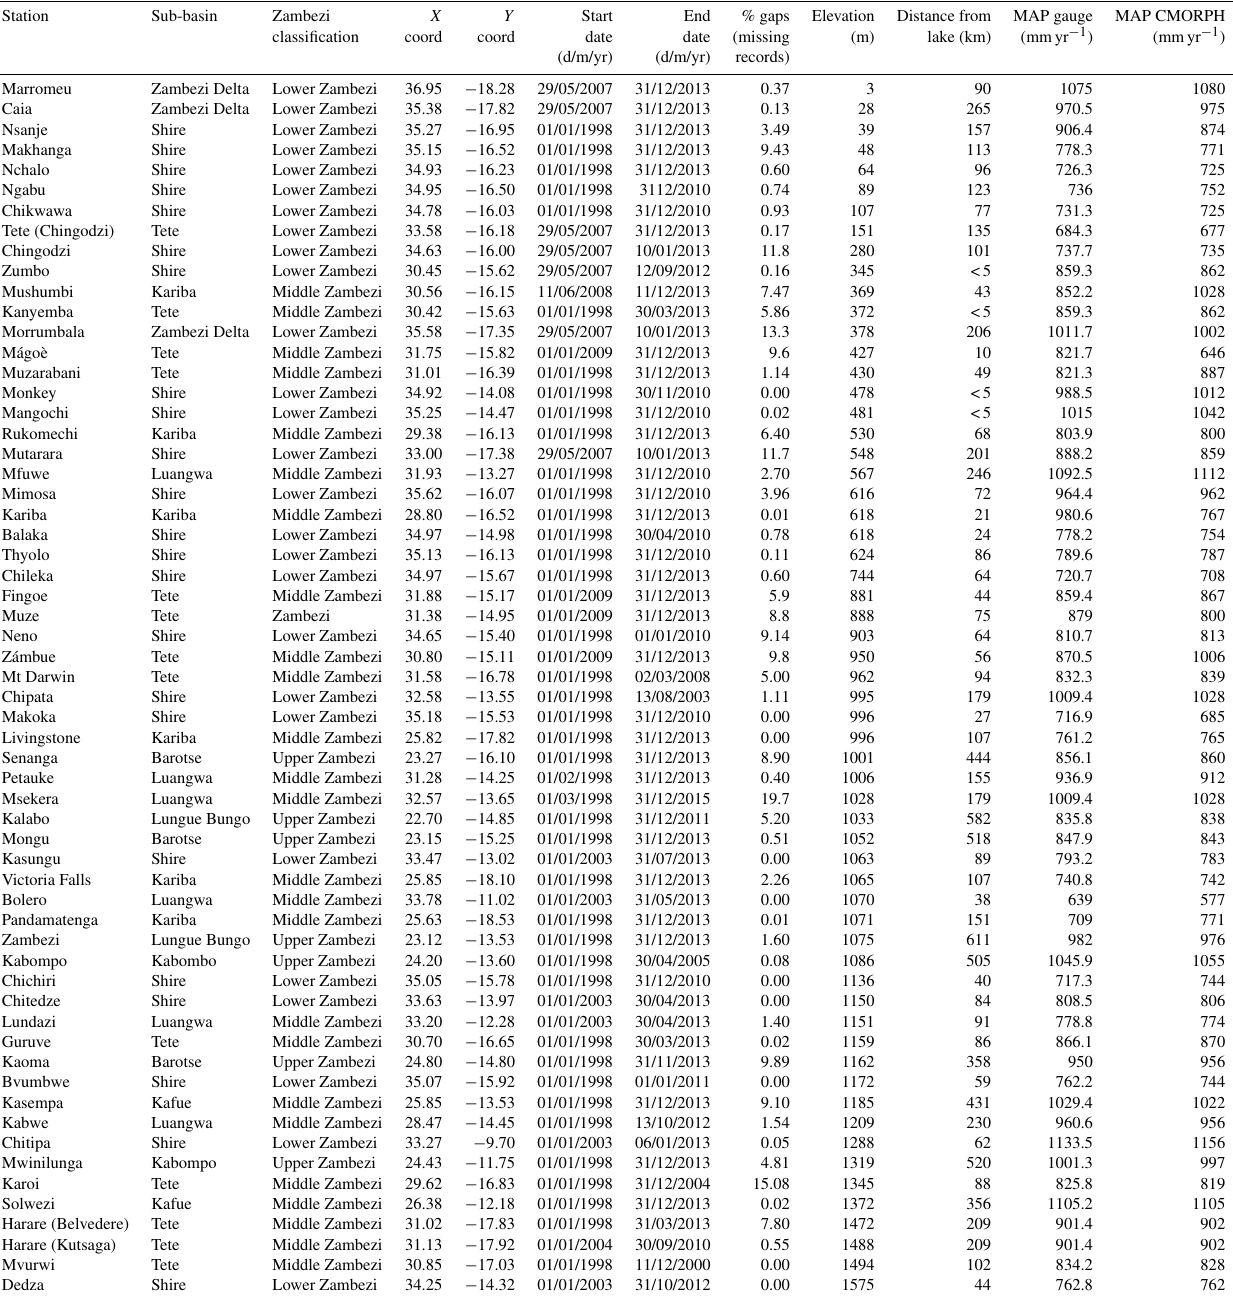
Table A1. Rain-gauge stations in the Zambezi sub-basins showing x and y locations, sub-basin they belong to, year of data availability, % of missing gaps, station elevation, and distance from large-scale water